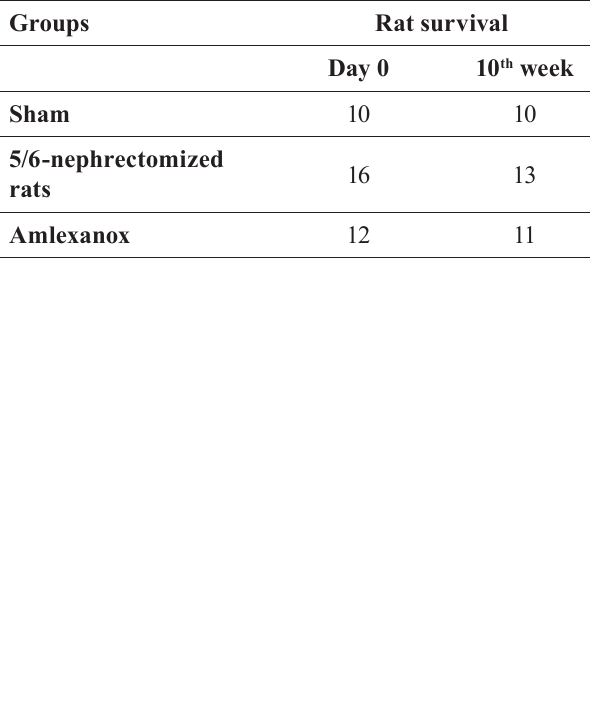
TABLE I - R at survival by the end of the